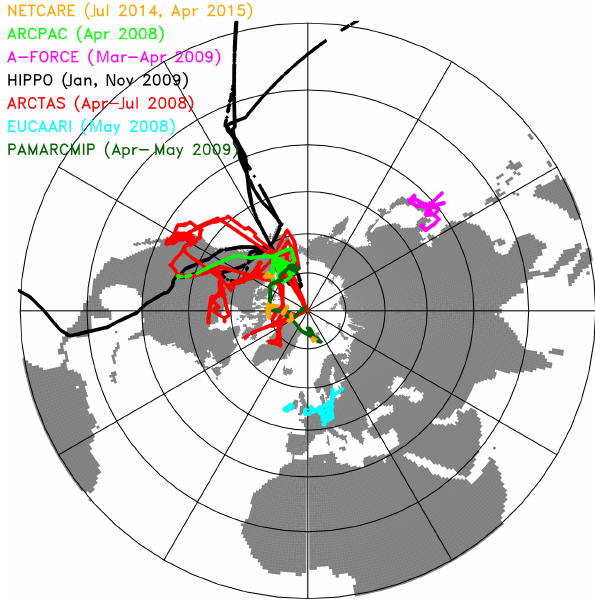
Figure 2. Flight tracks of BC aircraft campaigns used in this